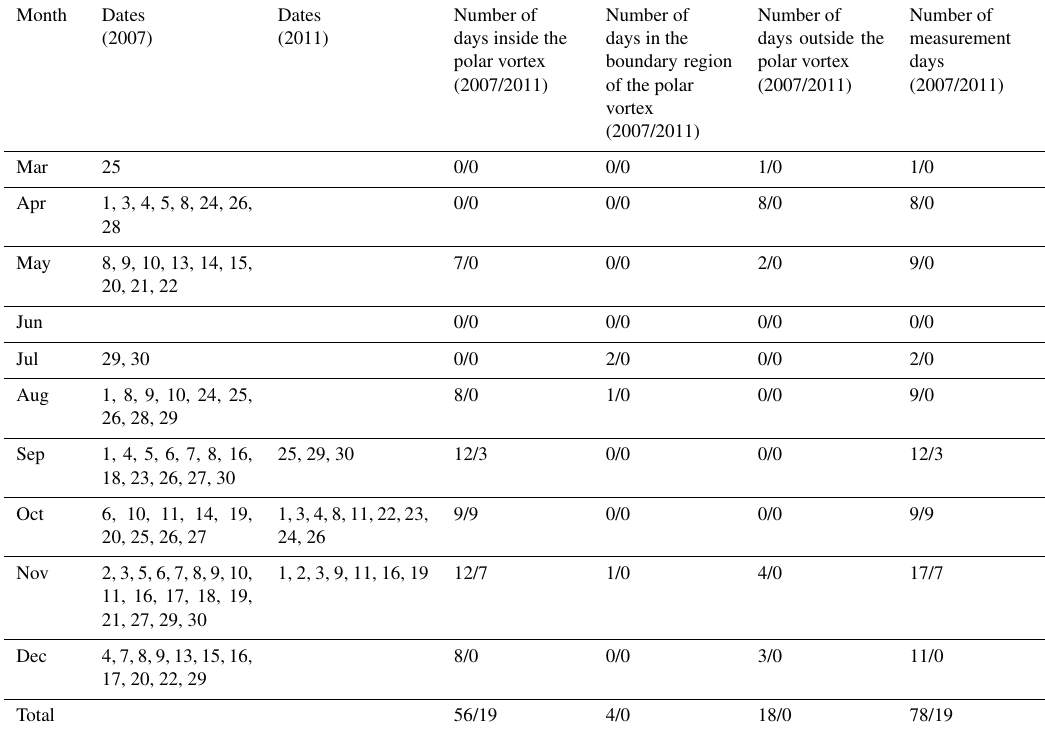
Table A1. FTIR observation dates at Syowa Station in 2007 and